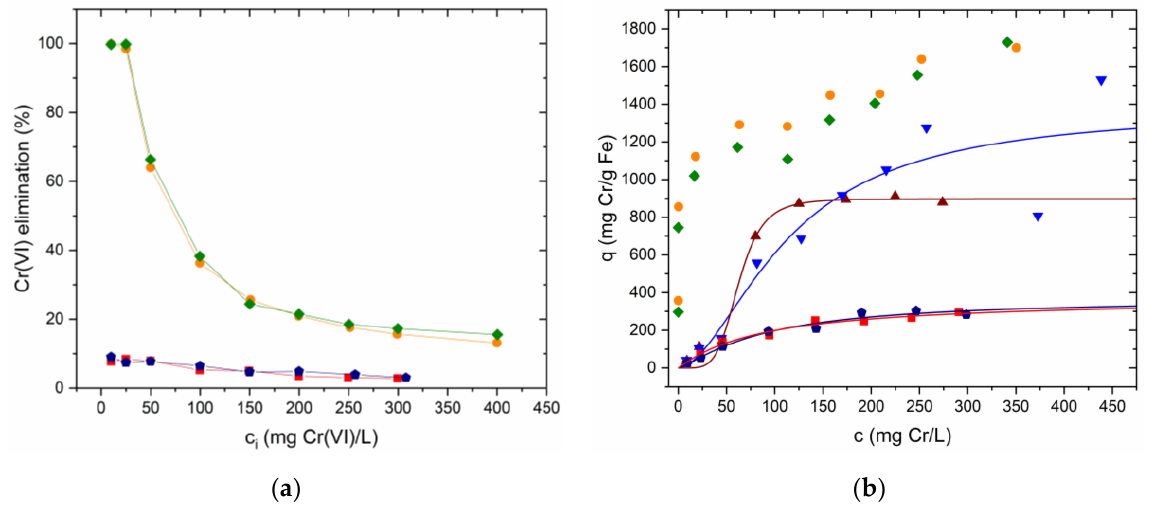
Figure 9. ( a ) Cr(VI) elimination percentages using GSLP-Fe(0) D3 ( ● ) and D2 ( ♦ ). Cr(VI) elimina- tion percentages using GSLP-Fe D3 ( ■ ) and D2 ( ⬟ ). ( b ) Equilibria experimental data. Solid lines were obtained by fitting to Equation (8). ( ■ ) Cr(VI) adsorption by GSLP-Fe D3. ( ⬟ ) Cr(VI) adsorp- tion by GSLP-Fe D2. ( ● ) Maximum Cr(VI) elimination by GSLP-Fe(0) D3. ( ♦ ) Maximum Cr(VI) elimination by GSLP-Fe(0) D2. ( ▲ ) Total chromium adsorption by GSLP-Fe(0) D3. ( ▼ ) Total chro- mium adsorption by GSLP-Fe(0) D2. The GSLP-Fe/Fe(0) D3 dose of 2 g·L − 1 equaled 27.8 mg·L − 1 of Fe. The GSLP-Fe/Fe(0) D2 dose of 2 g·L − 1 equaled 32.5 mg·L −1 of Fe. pH 1, room temperature, and stirring at 200 RPM for all the experiments. Initial Cr(VI) concentration from 10 to 500 mg·L −1 was used.